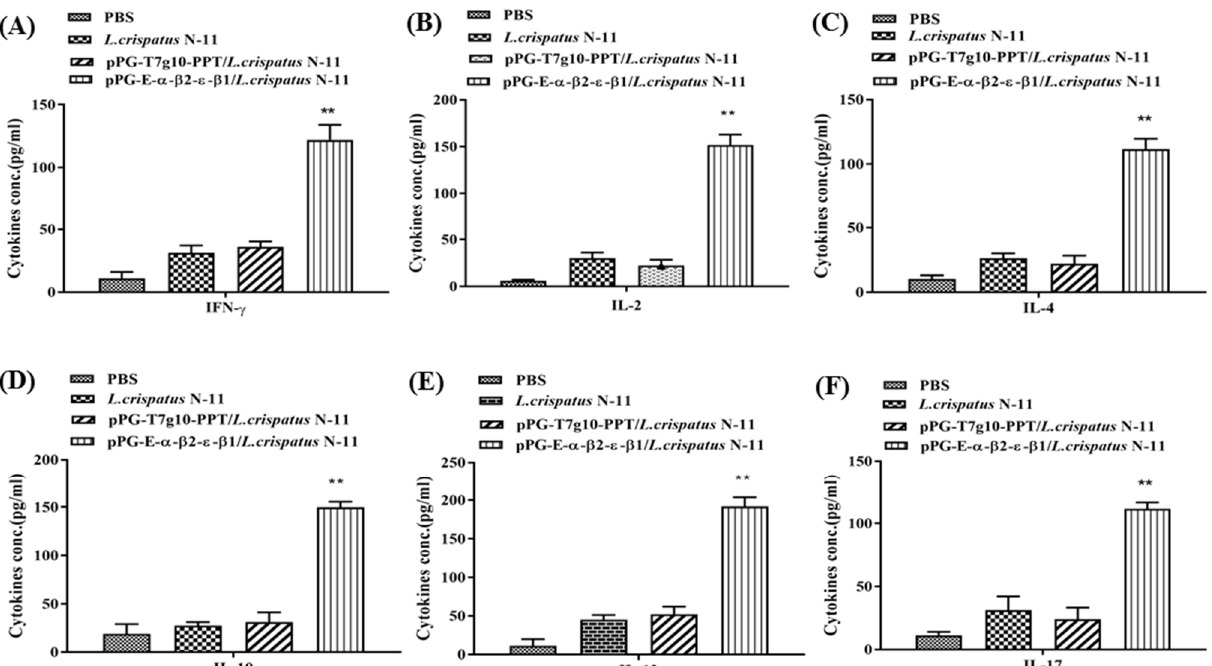
Figure 5. Detection of cytokine levels in the serum of pPG-E- α - β 1- ε - β 2/ L. crispatus N-11 immunized chickens. The levels of cytokines IL-2 ( B ), IL-4 ( C ), IL-10 ( D ), IL-12 ( E ), IL-17 ( F ), and IFN- γ ( A ) in the serum samples ( n = 3) on day 42 post-immunization were detected using an ELISA kit. The data are presented as the mean ± SD (** p < 0.01 as compared with groups pPG-T7g10-PPT/ L. crispatus N-11 and PBS).